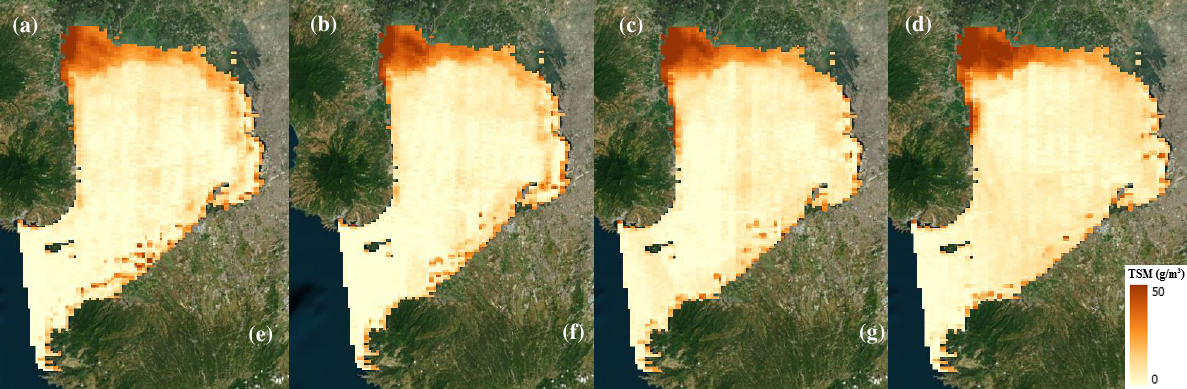
Figure 10. TSM maps for April 2, 2019 using the Yearly model: (a) 9:10, (b) 9:30, (c) 9:50, and (d) 10:10 AM.